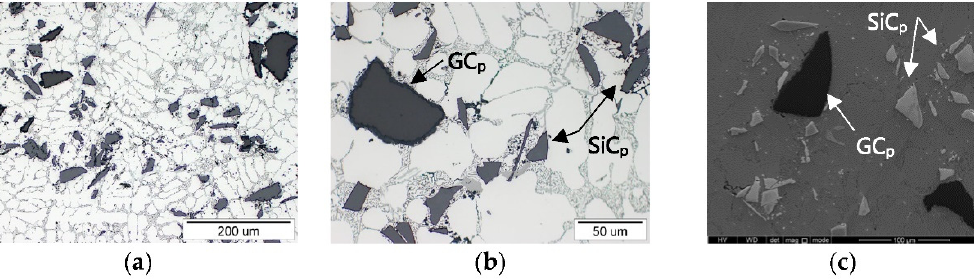
Figure 17. Microstructure of the AlSi12/SiC p + GC p hybrid composite: ( a ) and ( b ) LM; ( c ) SEM.